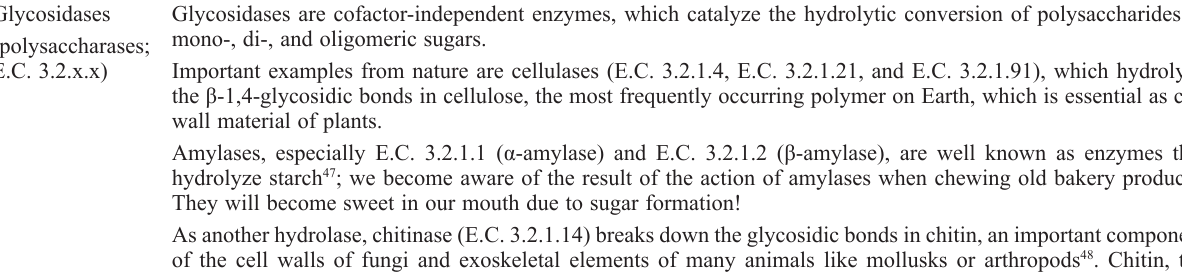
Table 1 – Hydrolases responsible for biodegradation of diverse polymers